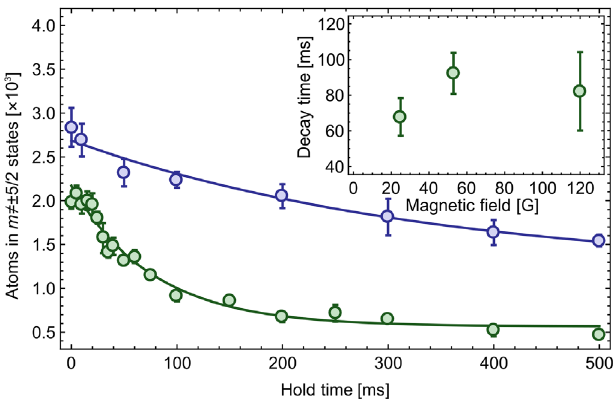
FIG. 8. Lifetime measurements of orbital molecules in different optical lattice configurations. Blue: Lifetime of isolated orbital ¼ 15 3D lattice. An exponential fit to the data molecules in a s f results in a decay time constant of 0 . 35 ð 0 . 07 Þ s. Green: Lifetime of interacting molecules in an array of pancakes. In this second scenario, molecules are free to interact with other atoms and molecules of the sample, leading to a shorter lifetime with respect to the 3D lattice case. The nonzero background of a few hundred atoms in the m ≠ (cid:2) 5 = 2 states can be ascribed to an imperfect preparation of the initial sample. Inset: Measured lifetime of orbital molecules in pancakes for different values of magnetic field across the orbital Feshbach resonance. The lifetime values are compatible within the error bars, and no evident trend is